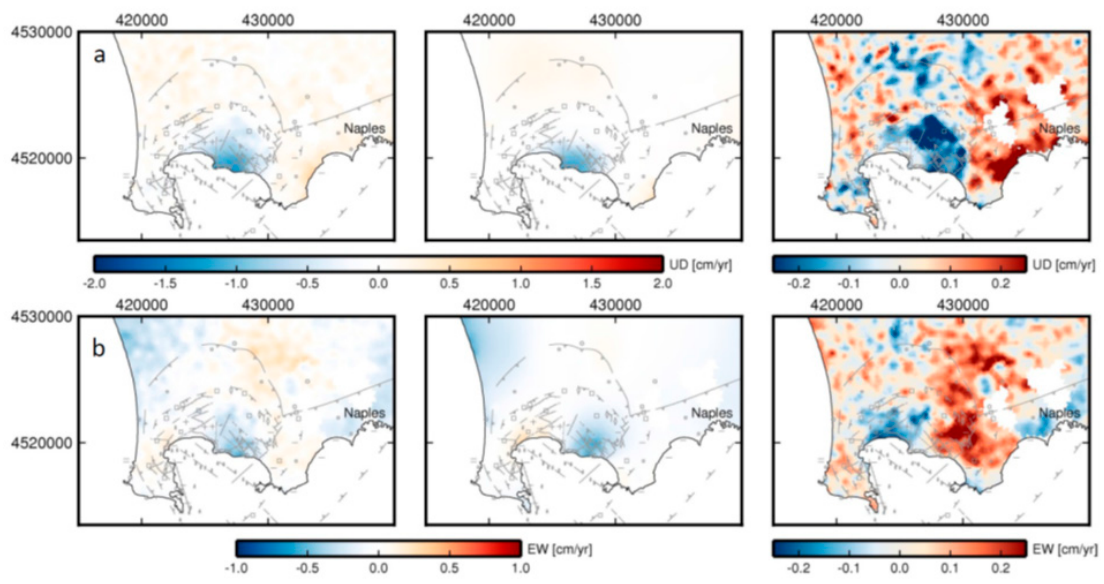
Figure 11. ( a ) Observed vertical displacement rate (left), cm / yr, for the subsidence period, 2000–2005; modelled vertical displacement rate from inversion (center); and residual of observed and modelled displacements (right). ( b ) Observed EW displacement rate (left), cm / yr, 2000–2005; modelled EW displacement from inversion (center); and residual of observed and modelled displacements (right). Images were saturated at the corresponding scales in order to improve comparison and highlight di ff erences among panels [53].